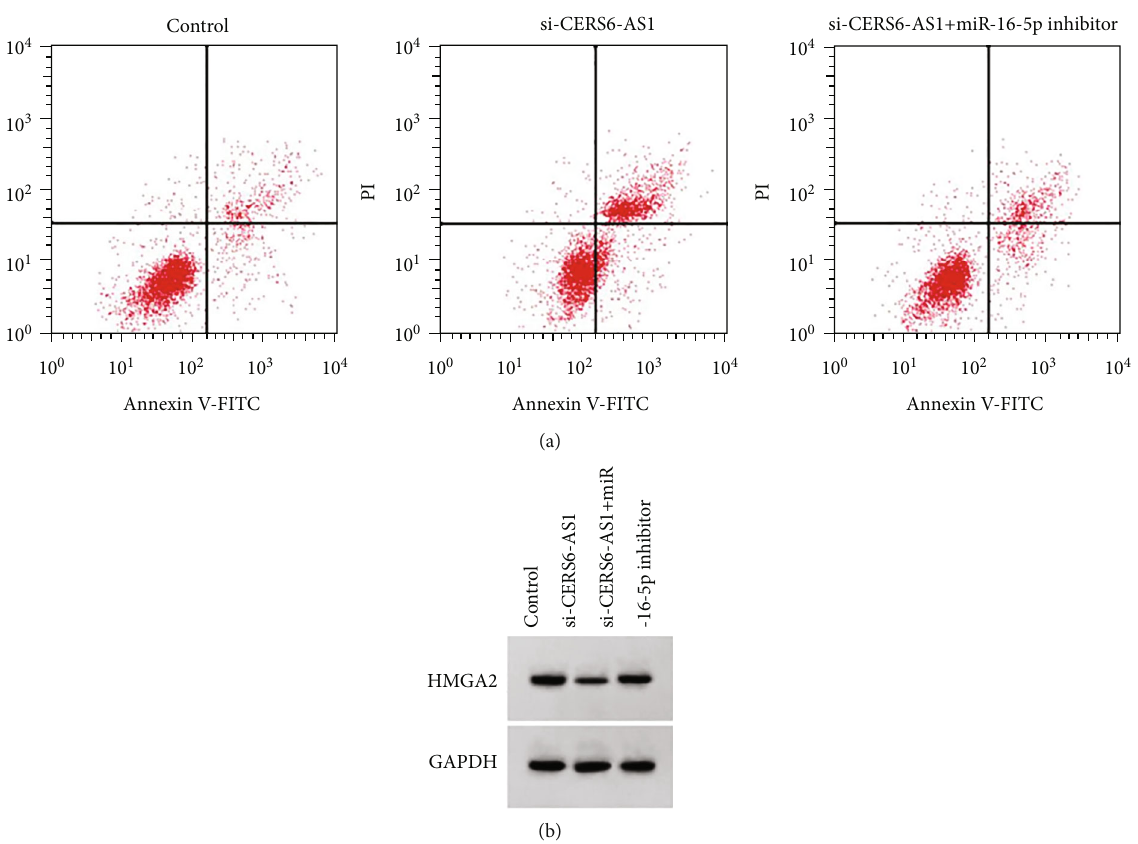
Figure 6: Inhibition of miR-16-5p can reverse the induction of apoptosis of DU145 by silencing CERS6-AS1 and the inhibition of HMGA2 protein. Table 4: Inhibition of miR-16-5p can reverse the e ff ect of silencing CERS6-AS1 on proliferation, migration, and apoptosis of DU145 ( (cid:1) x ± s , n = 9